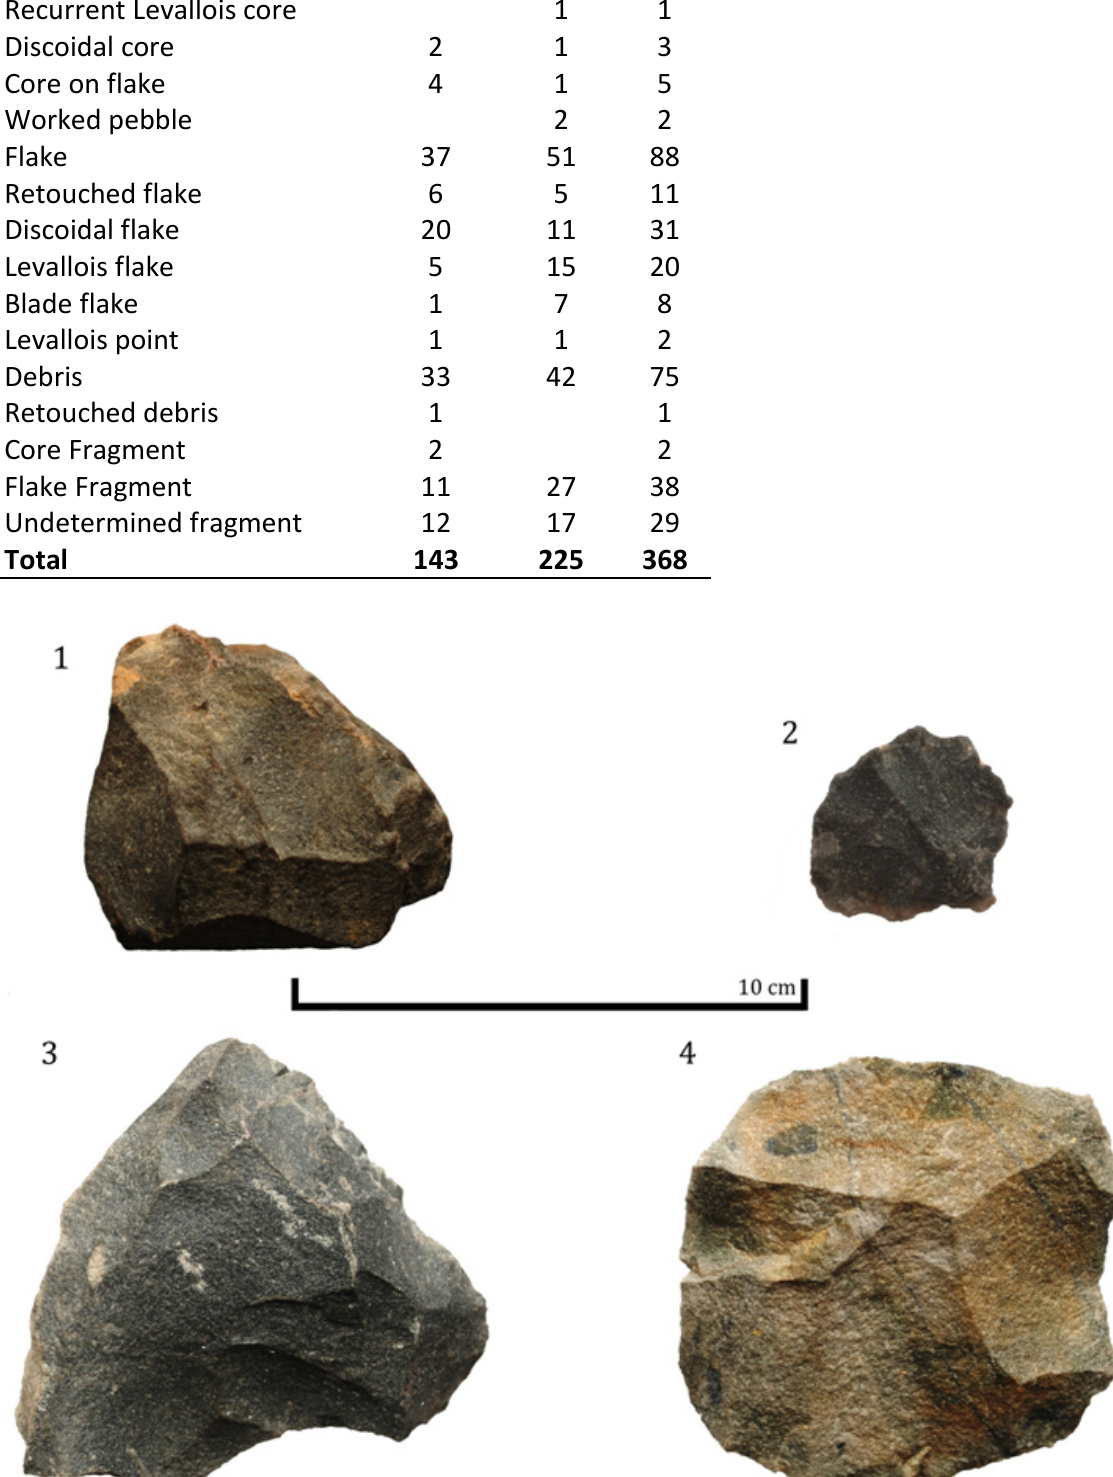
Figure 5. 1: Quartzite multifacial core; 2 & 3: Quartzite Levallois cores; 4: Quartzite discoid